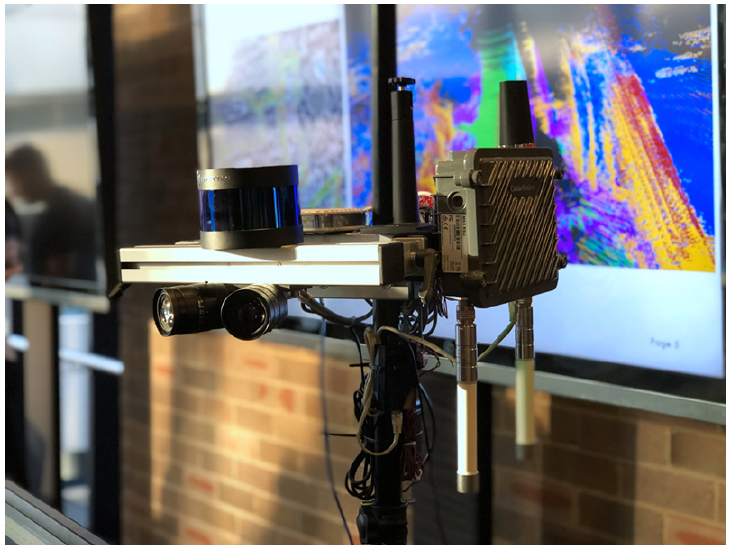
Figure 1. The developed IRSU is equipped with multiple sensors including dual cameras and a 16-beam lidar. The sensors sit on a tripod for easy deployment in the